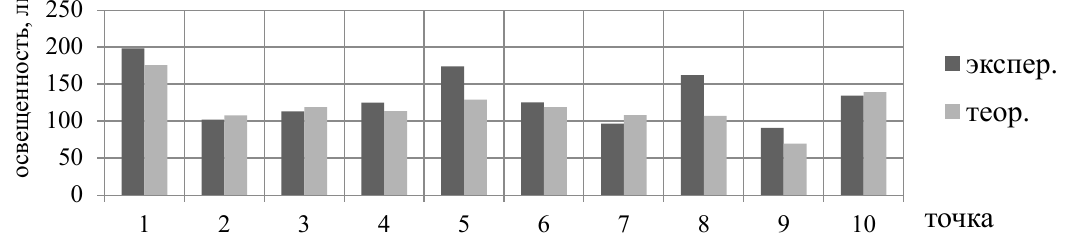
Figure 9. Diagram of changes in illumination at different heights.